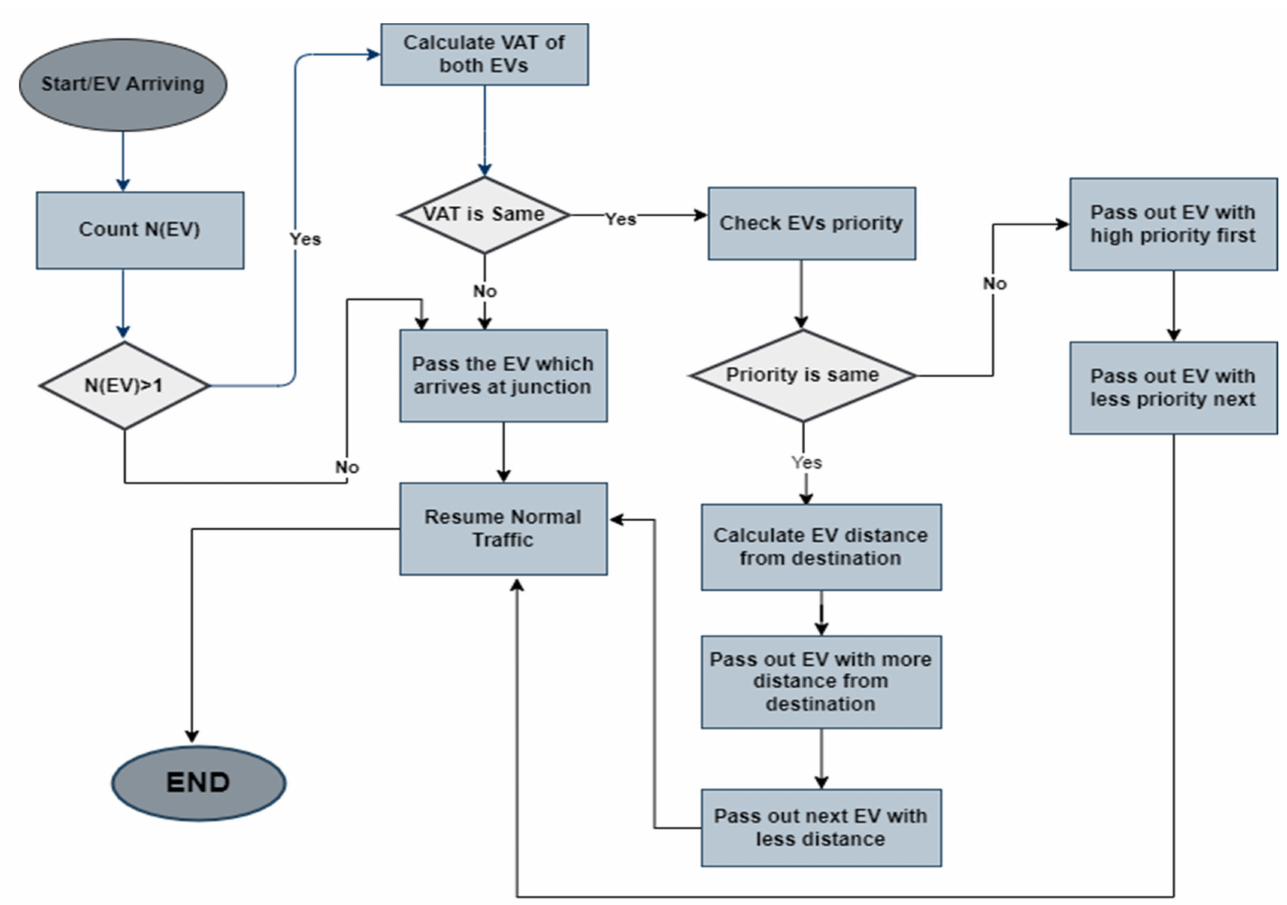
Figure 5. Working of EVMS.